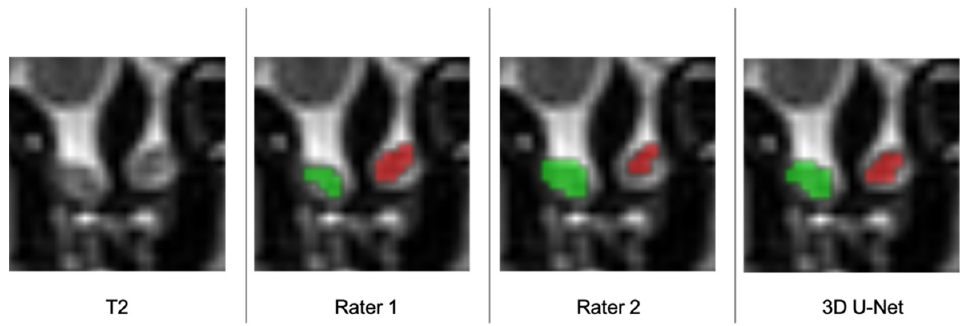
Figure 4. Top : Boxplot showing the OBVs of manual segmentations measured by two independent raters and the 3D U- Net model on test dataset. Bottom left and right : XY-Plot of the left and right OBV measured by two independent raters and 3D U-Net on test dataset. The trend of the graphs shows a high level of congruency of the measurements.